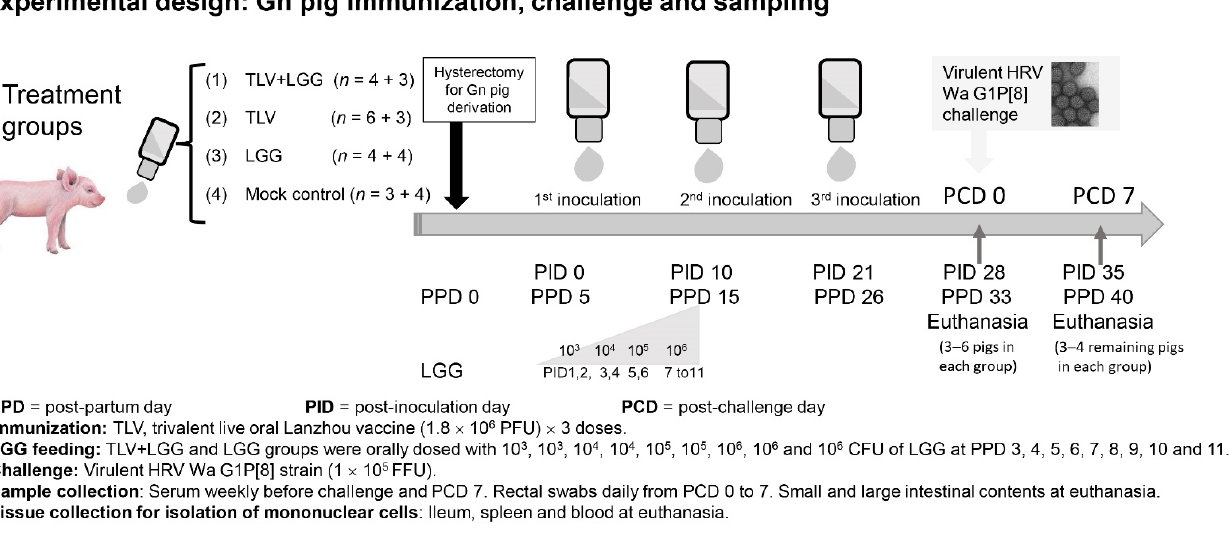
Figure 1. Experimental design: Gnotobiotic (Gn) pig immunization, Lactobacillus rhamnosus (LGG) feeding, challenge, and sampling.